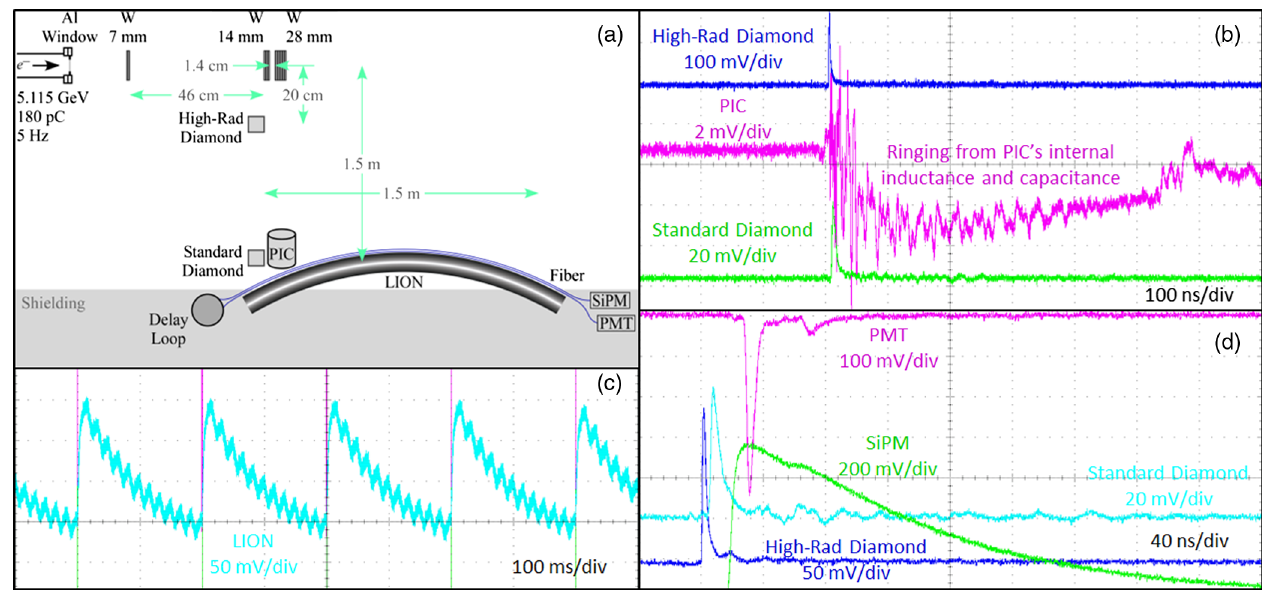
FIG. 12. (a) Layout of an experiment comparing old and new detectors as 5.1-GeV, 180-pC electron bunches hit tungsten plates. Signals from (b) a PIC and diamonds; (c) a LION, with a very slow timescale and large 60-Hz noise; and (d) a PMT and a silicon photomultiplier